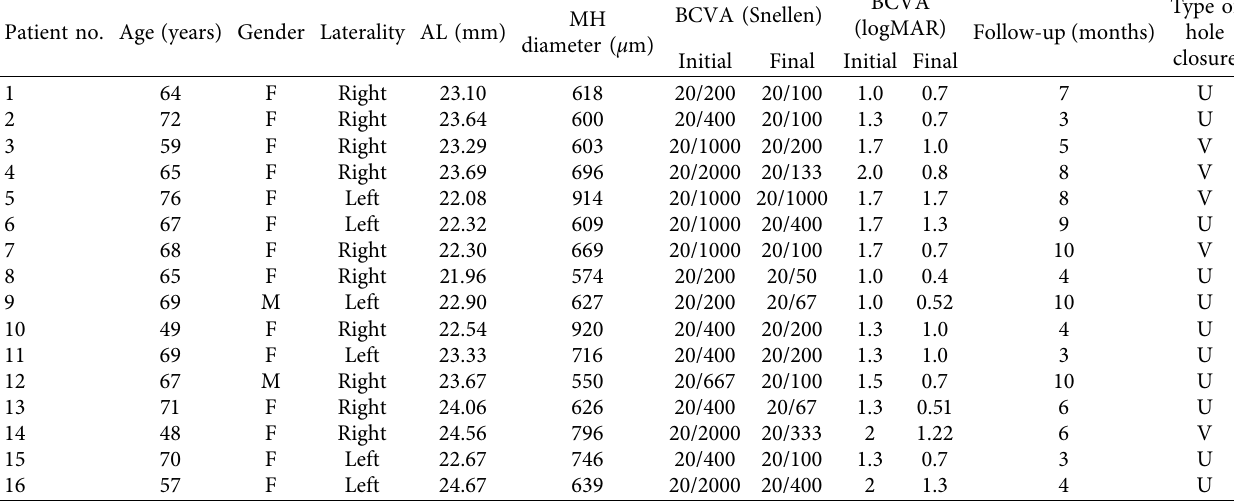
Table 1: Demographics of patients with a large macular hole.